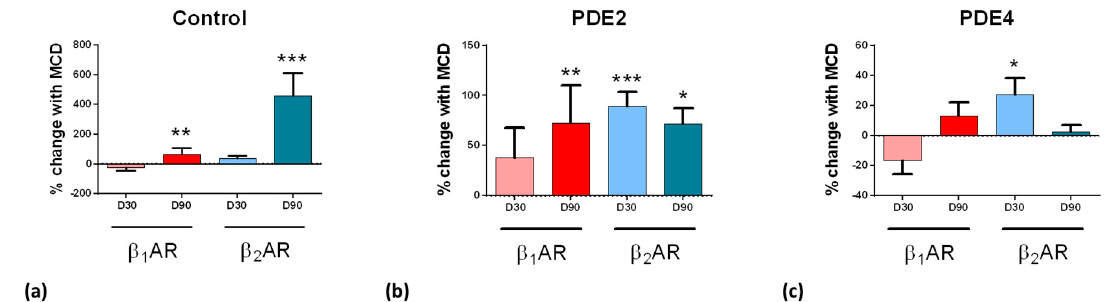
Figure 5. The dependence of PDE2 and 4 activities towards β 1 AR and β 2 AR-stimulated cAMP level on the removal of cholesterol in D30 and D90 iPSC-CMs. ( a ) Difference in the normalised FRET ratio with and without cholesterol removal and subsequent stimulation with isoprenaline (30 nM) in the presence of ICI (50 nM) or CGP (100 nM), respectively, in iPSC-CMs at D30 and D90; (62/11), (55/5), (28/3), (51/3). ( b ) Same with the inhibition of PDE2 with EHNA (10 µM) (15/3), (9/3), (9/3), (8/3); ( c ) Same with inhibition of PDE4 with rolipram (10 µM) (28/4), (23/3), (17/3), (40/3). The percentage change in the FRET ratio was normalised to the maximal cAMP produced upon AC activation with NKH (10 µM). Data are presented as mean ± SEM. Significance was determined by One-Way ANOVA with Bonferroni’s post-hoc test. * p < 0.05, ** p < 0.01, *** p < 0.001, n/N = cells/batches.